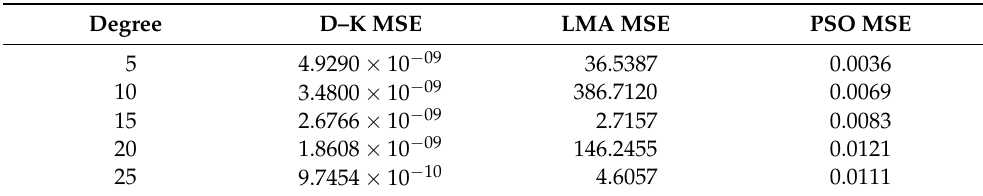
Table 4. MSE comparison for the D–K method and the ANN-based approach trained with LMA and PSO for polynomials with real and complex